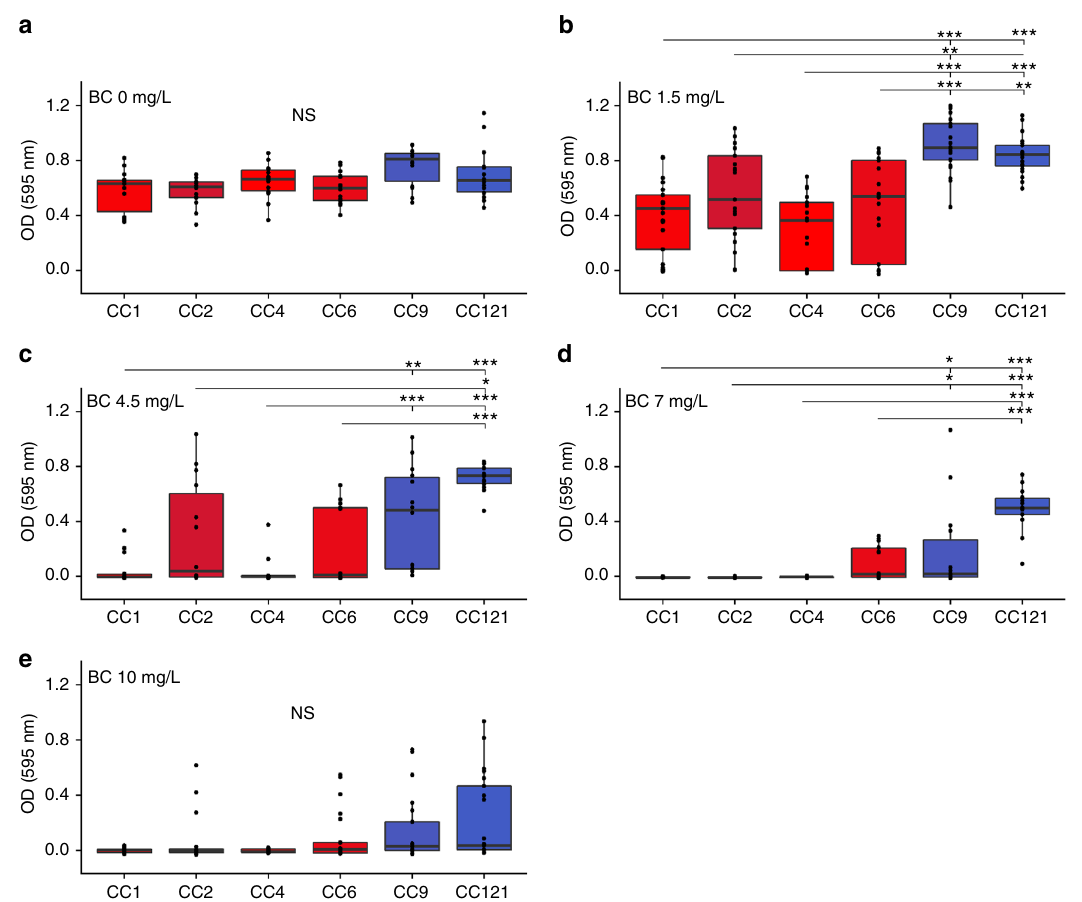
Fig. 4 Bio fi lm formation ef fi ciency in absence and presence of BC. Bio fi lm formation capacity in absence and presence of 1.5, 4.5, 7, and 10 mg/L of benzalkonium chloride (BC) is shown for 42 isolates representative of CC1, CC2, CC4, CC6, CC9, and CC121 (seven isolates per CC). Bio fi lm was quanti fi ed after 48 h of static growth in modi fi ed MCDB 202 medium with or without BC using a violet crystal labeling-based method and is shown as OD 595nm (see Methods section). Colors are as in Fig. 1a. The boxes delimit the fi rst (25%) and third (75%) quartiles, and the bars delimit the second quartile (median). Outliers are outside the whiskers. Statistical differences between hypervirulent (CC1, CC2, CC4, and CC6) and hypovirulent (CC9 and CC121) clones are shown (Mann – Whitney U test with holm ’ s correction). *** p < 10 − 3 ; ** p < 10 − 2 ; * p < 0.05. n = 7 strains per clone tested three